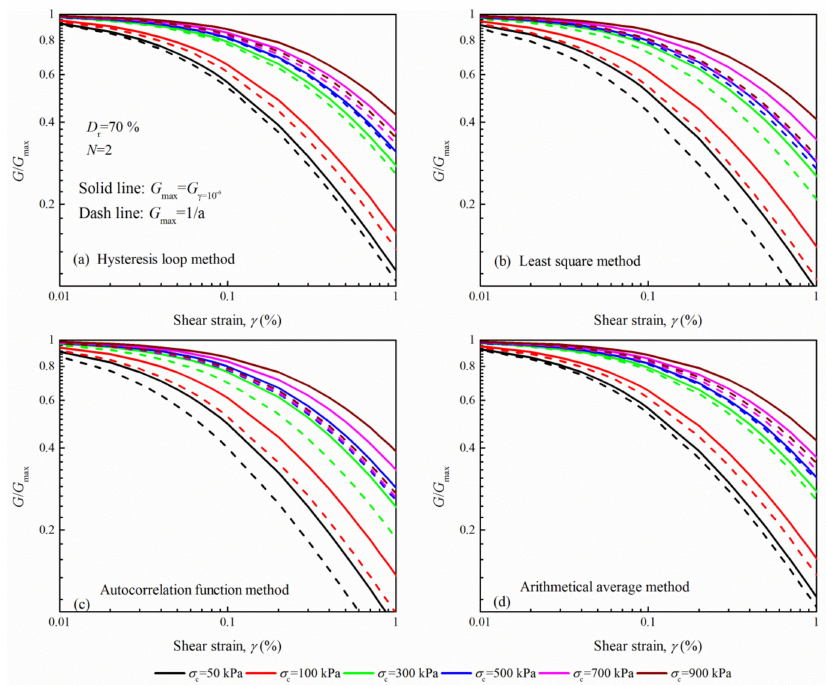
Figure 14. Comparison of G / G max between 1/a and G γ =10 − 6 for various σ c ( a ) Hysteresis loop method, ( b ) Least square method, ( c ) Autocorrelation function method, ( d ) Arithmetical aver- age method.